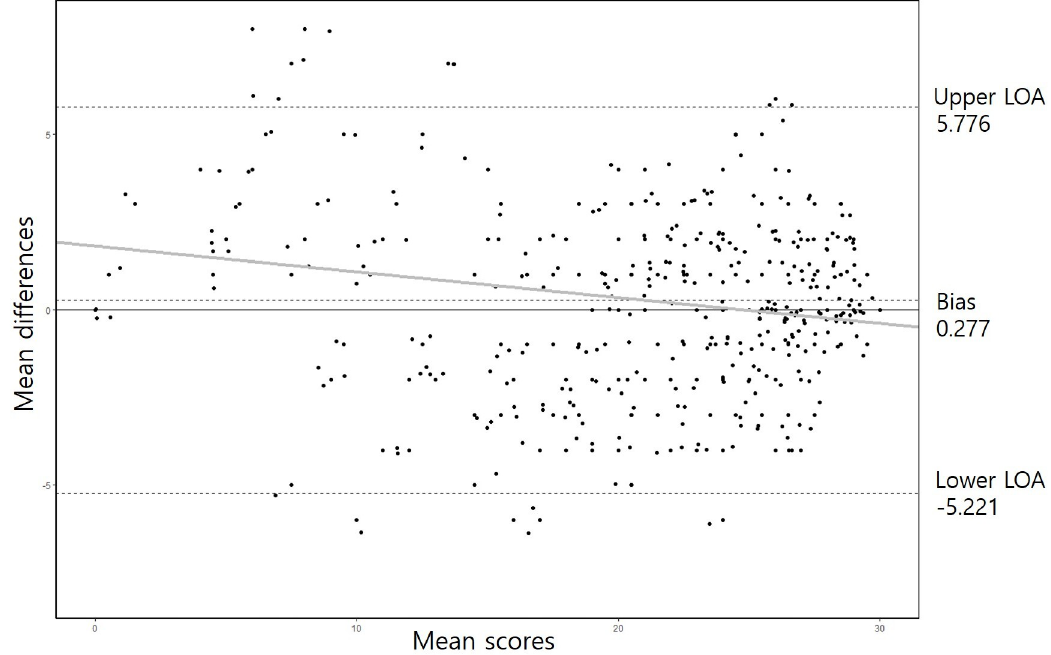
Fig 2. A Bland-Altman plot of the difference in the raw and converted MMSE-2 scores. The solid line indicates the reference (no mean difference), the middle-dotted line is the mean difference, and the upper- and lower-dotted lines are the limits of agreement representing ± 1.96 standard deviations (SDs) from the mean difference within which 95% of the differences between the two scores are expected to fall. The gray solid lines are the fitted regression lines, indicating a significant linear